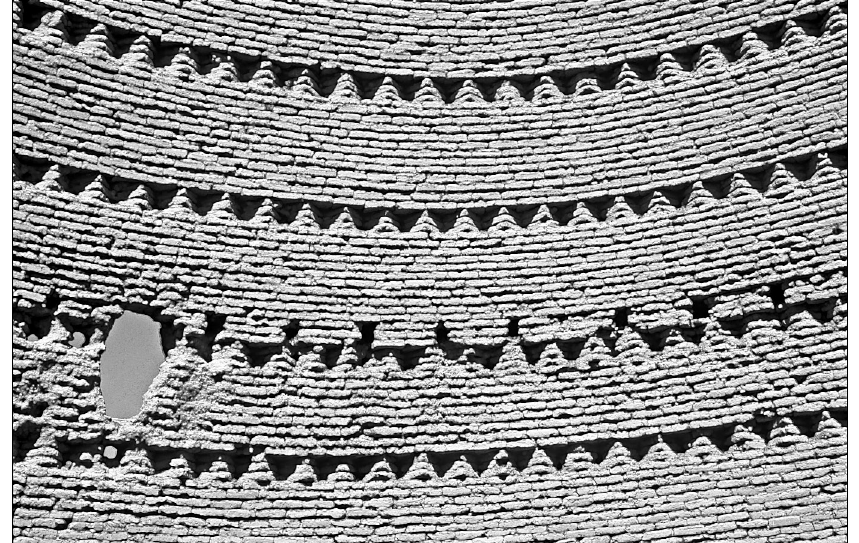
Figure 4 Part of the interior of a Timurid icehouse at Merv, showing the high quality of its mudbrick construction.